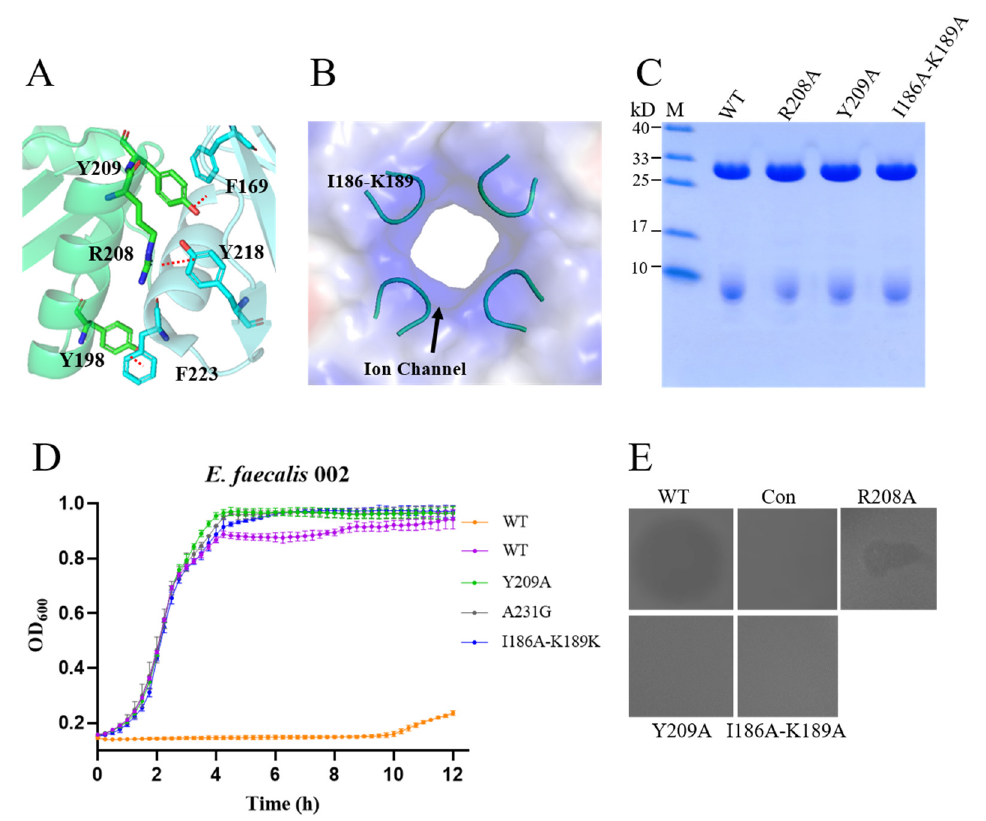
Figure 8. Putative ion channel and interaction between EFm1 monomers. ( A ) Putative ion channel in the CTD of EFm1; ( B ) The interaction between monomers of EFm1; ( C ) SDS-PAGE results of the mutants R208A, Y209A and I186A-K189A, respectively; ( D ) Growth curves of the mutants R208A, Y209A and I186A-K189A, respectively; the mean ± s.e.m is shown; ( E ) Plate lysis assay results of the mutants R208A, Y209A and I186A-K189A, respectively. There is a putative iron channel (I186-K189) in the CTD of EFm1 (Figure 8B) which was filled with positively charged residues. SDS-PAGE showed that this four-residue mu- tation did not interfere with the formation of the holoenzyme (Figure 8B), while the plate lysis assay showed that the mutants were not active (Figure 8D).